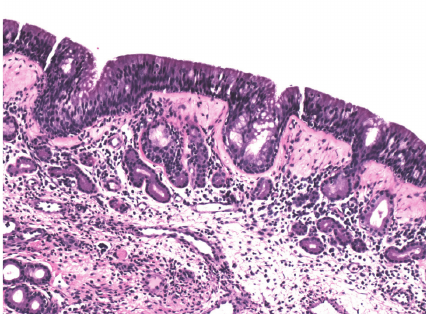
Figure 3: A histologic specimen of respiratory mucosa with thick- ened basement membrane and mild chronic inflammation.